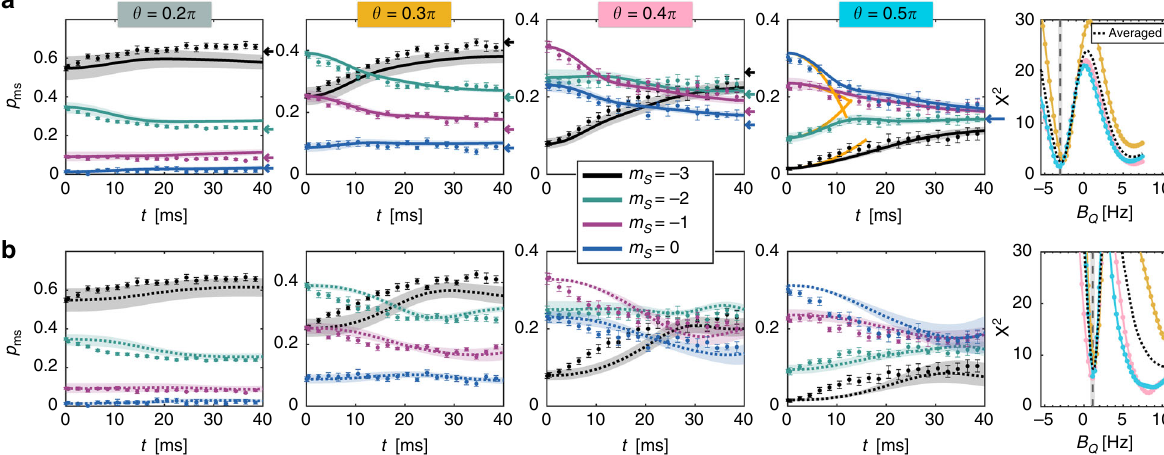
Fig. 2 Comparison between classical and quantum dynamics. For various initial tilting angles θ = 0.2 π , 0.3 π , 0.4 π , and 0.5 π , we plot the experimental data for the four lowest spin populations, p m , and compare them with simulations. a Comparison with GDTWA simulations (solid lines) on a 7 × 3 × 7 cluster S allowing the quadratic Zeeman fi eld B Q to be the only fi tting parameter [here: B Q = − 3.0 Hz]. b Comparison with the classical mean- fi eld results (dotted lines) [here: B Q = 1.1 Hz]. The two plots on the right show quantitative comparison between data and simulations for θ = 0.3 π , 0.4 π , and 0.5 π with a reduced χ 2 criteria, for different values of B Q . We excluded the θ = 0.2 π case here since it shows no signi fi cant dynamics. The best agreement with GDTWA simulations is a factor of three better than with classical simulations. The deviation with the classical simulations is most obvious at short times, and clearly increases with increasing θ . The arrows indicate the expected equilibrium population maximizing entropy, for each angle. The orange solid line in panel ( a ) (for θ = 0.5 π ) is the result of the perturbative expansion, Eq. (3). The shaded area indicates the range of variation of the populations for evolutions with Δ B Q = ±0.3 Hz and uncertainties in the tilting angles with θ = (0.2 ± 0.018 π ), (0.3 ± 0.012) π , (0.4 ± 0.012) π , and (0.5 ± 0.01) π (estimated from the experiment). Error bars correspond to statistical standard